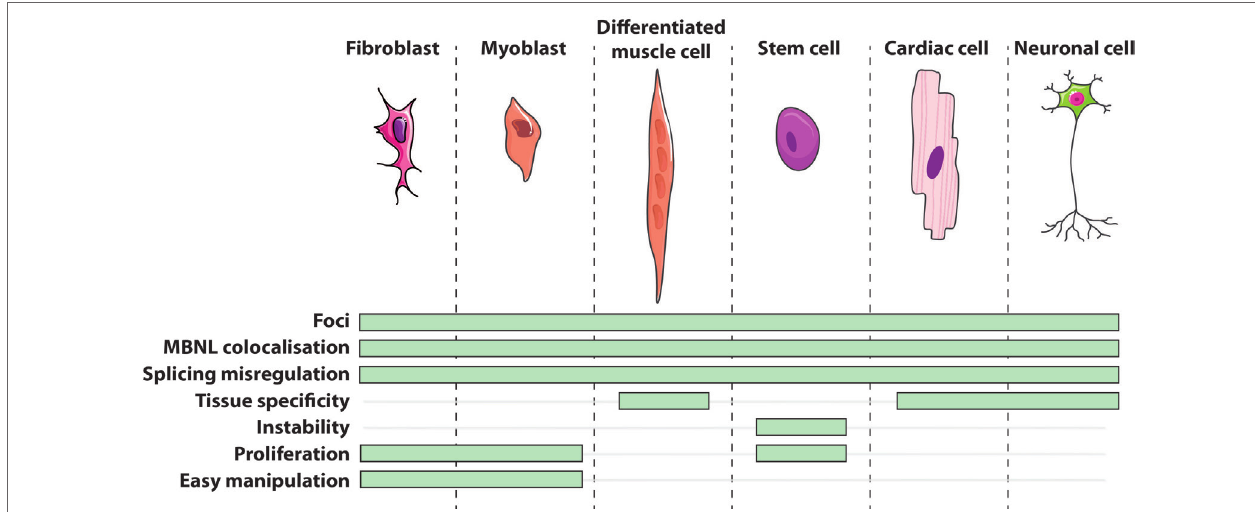
FiGURe 1 | Features of DM1 cells in